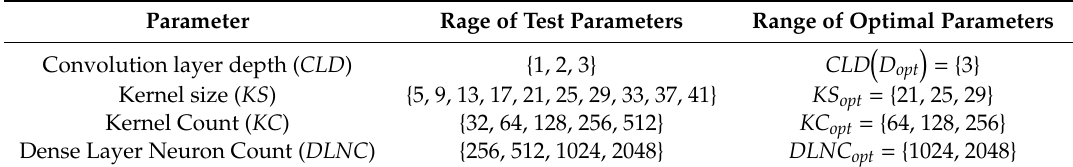
Table 5. Experimental parameters and optimization parameter range of proposed 1-Dimension Convolutional Neural Network (1D CNN) model.